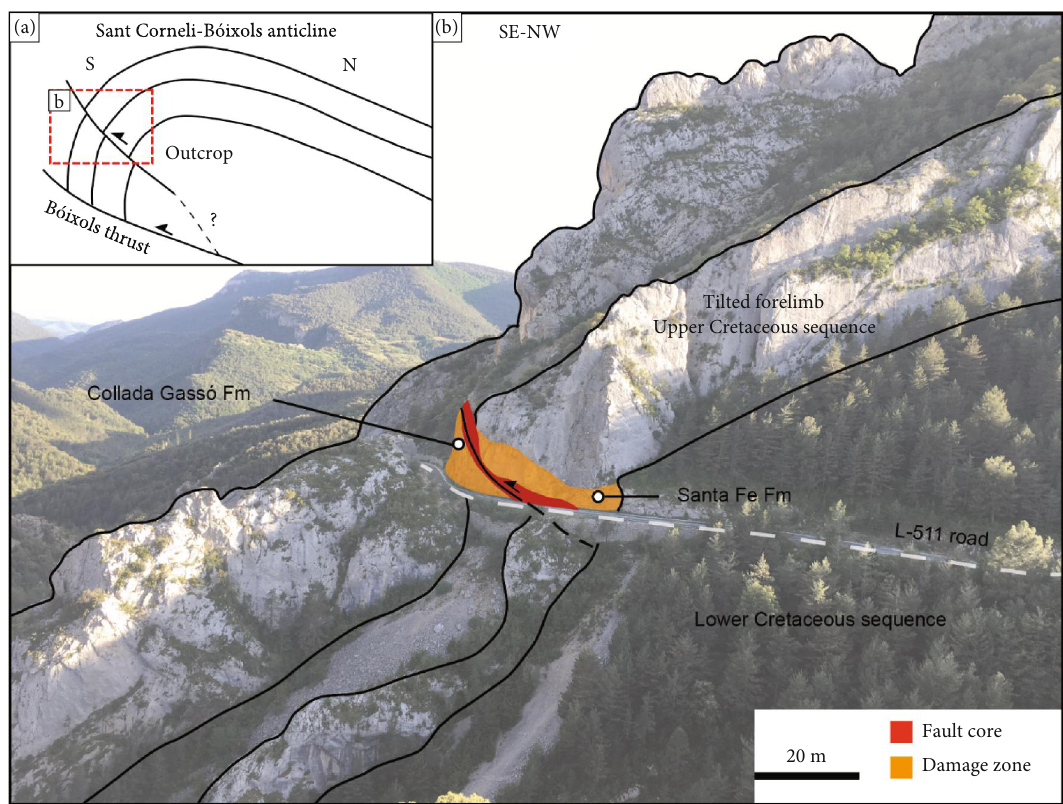
Figure 3: (a) Sketch and (b) panoramic view of the studied thrust o ff setting the southern limb of the Sant Corneli-Bóixols